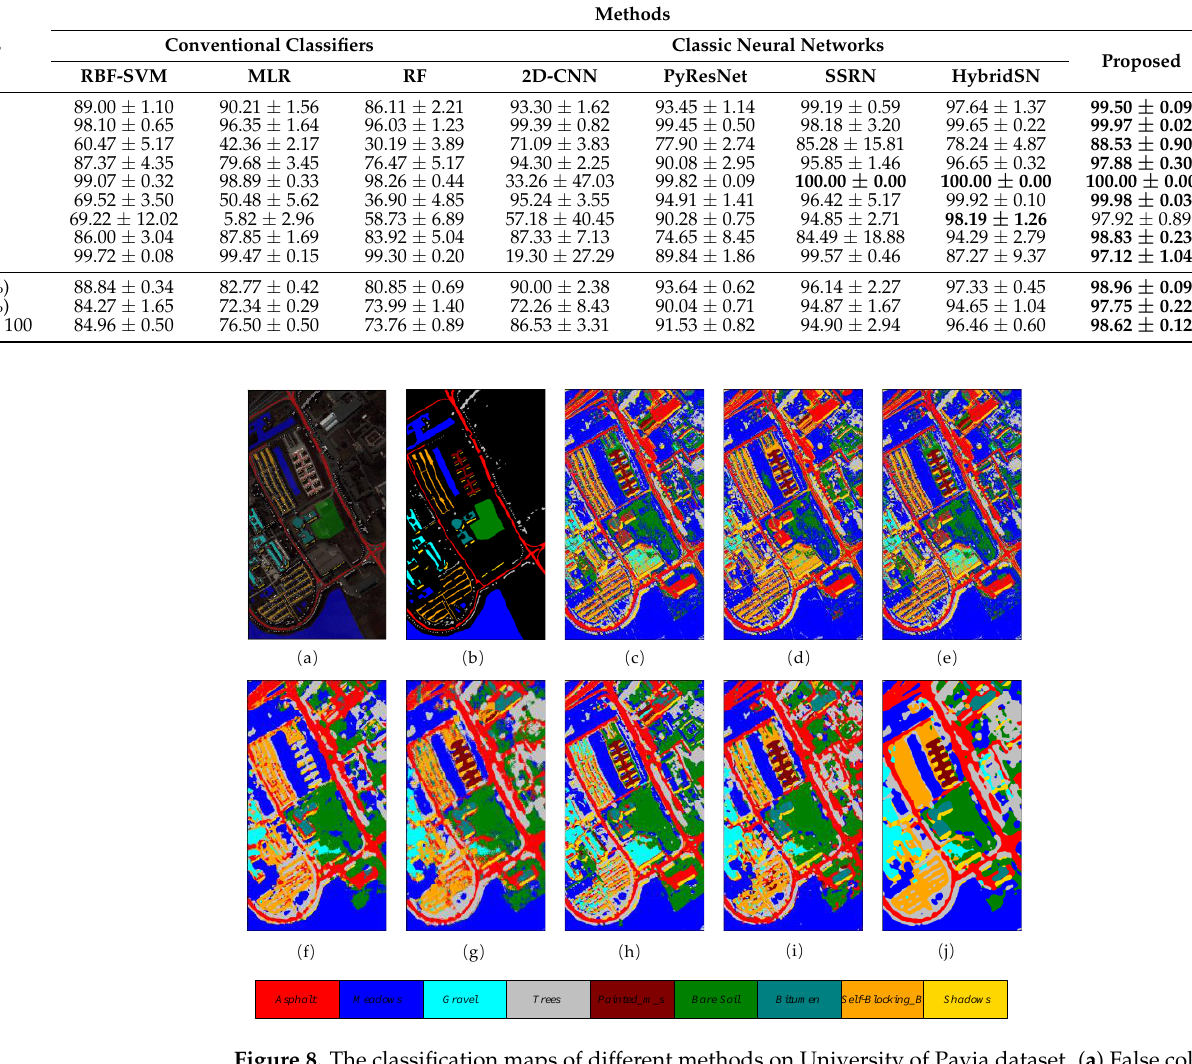
Figure 8. The classification maps of different methods on University of Pavia dataset. ( a ) False color map with truth labels, ( b ) ground truth, ( c ) RBF-SVM ( d ), MLR ( e ), RF ( f ) 2D-CNN ( g ), PyResNet ( h ) SSRN, ( i ) HybridSN, and ( j ) proposed.